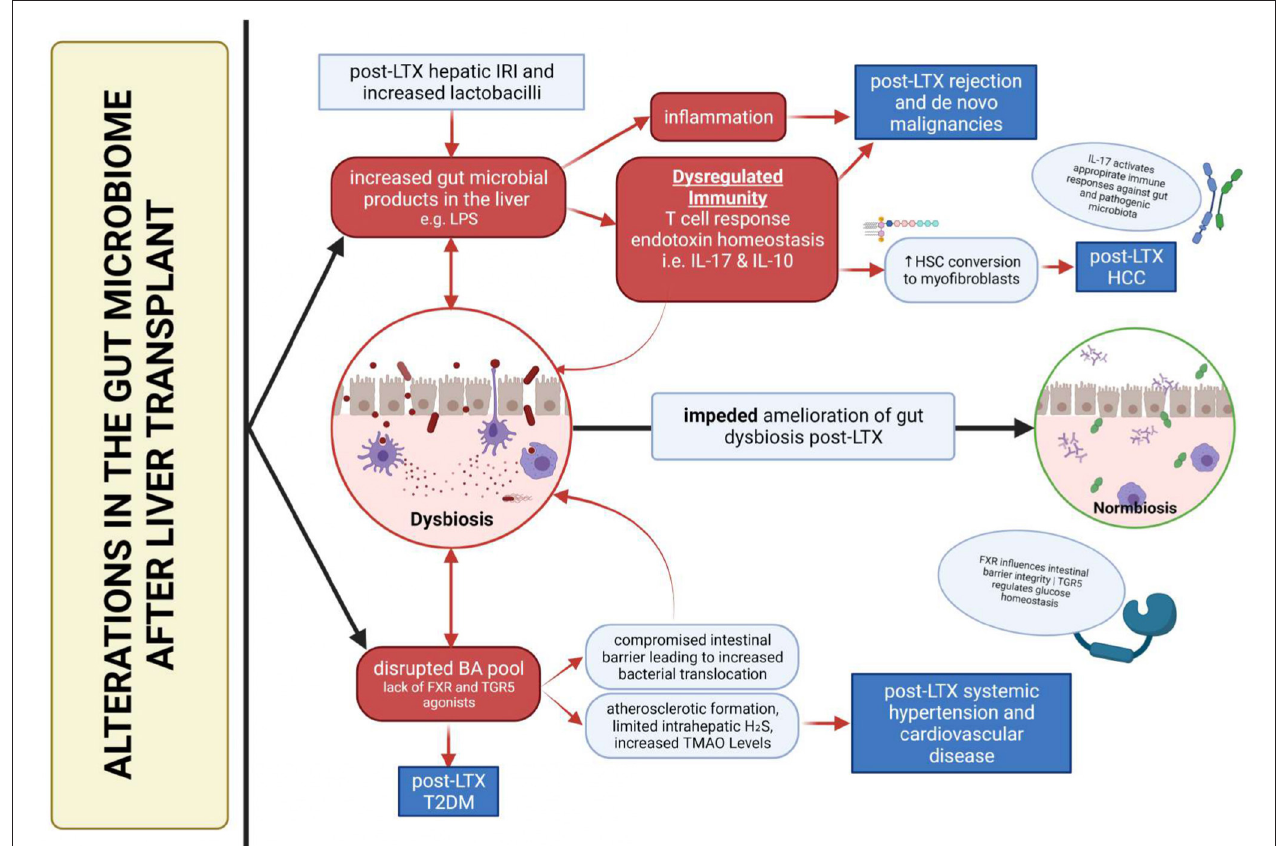
FIGURE 2 | Summary of dysbiosis-mediated development of post-liver transplant